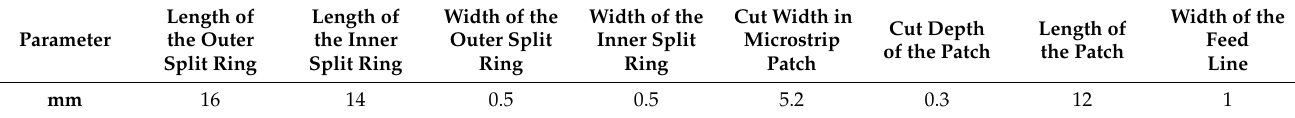
Figure 1. ( a ) Geometric configuration, ( b ) back view, and ( c ) side view of the microstrip-based sensor. Table 1. The parametric specification for the proposed microstrip-based